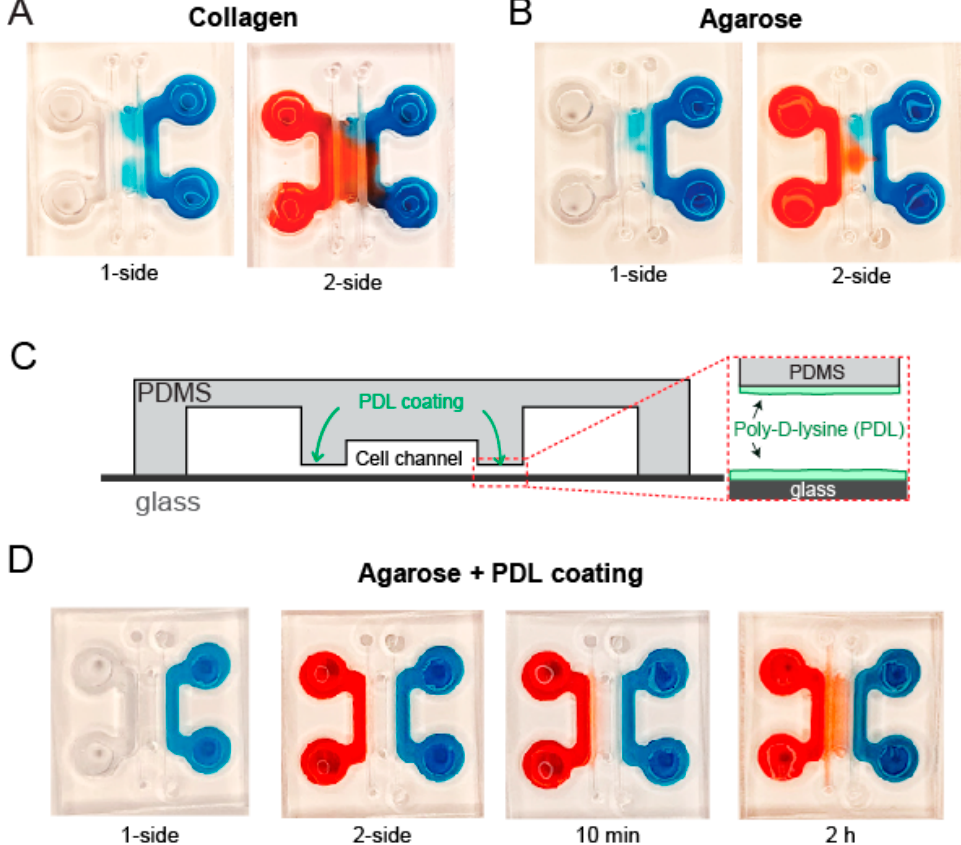
Figure 3. Effect of hydrogel type and poly-D-lysine precoating. Leakage of dye solution into the center channel when the hydrogel barriers were formed with ( A ) collagen and ( B ) agarose hydrogel without precoating in the device. ( C ) Illustration of poly-D-lysine (PDL) precoating in the gel channels. ( D ) PDL precoating prevented leakage in the agarose hydrogel barrier.